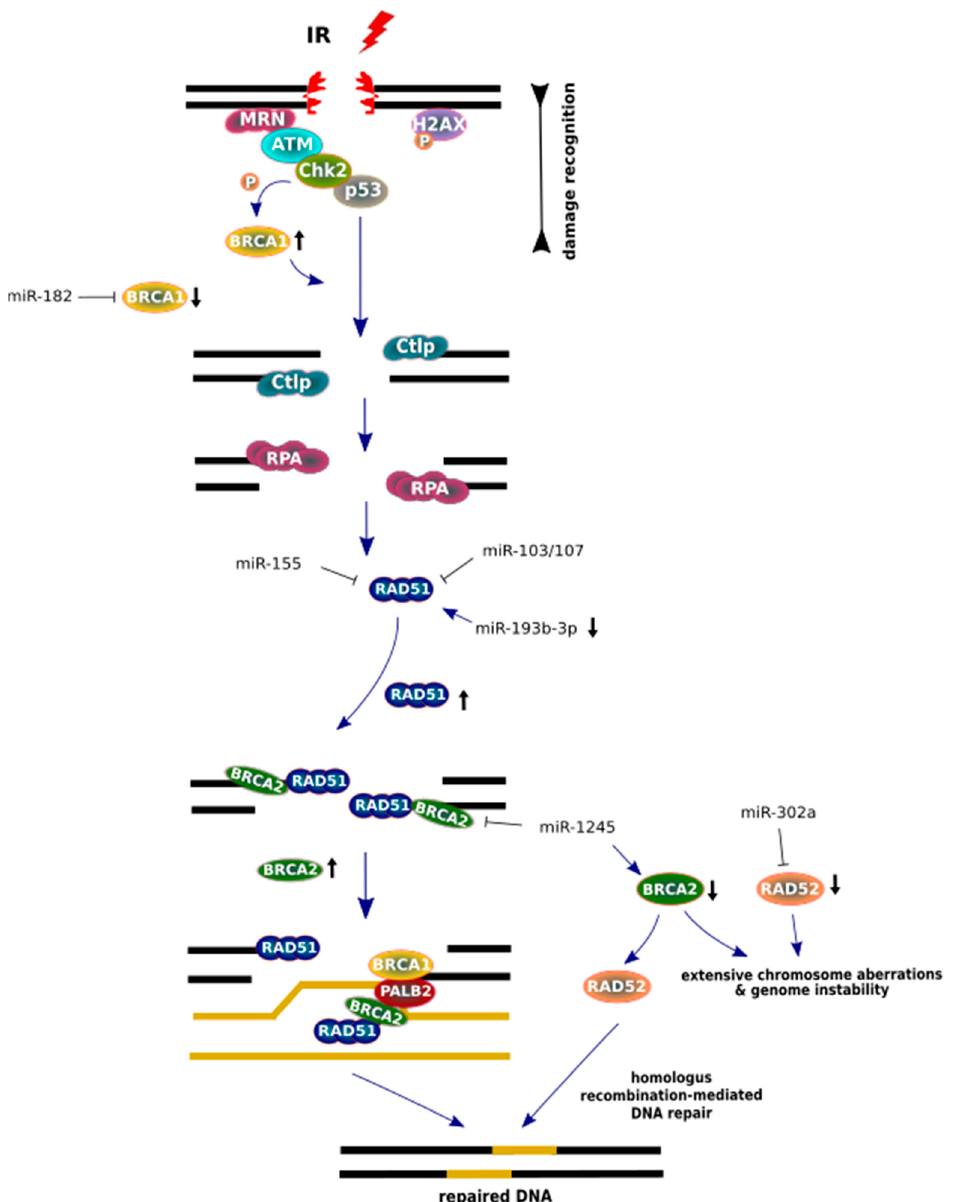
Figure 5. MiRNA regulation of homologous recombination (HR) repair factors after IR. After double strand break (DSB) recognition, BRCA1 (black arrow, pointing up) is phosphorylated by Chk2 kinase and an endonuclease CtIP is delivered for promotion end resection. While, at a later step of HR, BRCA1 recruits PALB2, which mediates promotion of BRCA2 to arrangement on the DNA template. Active BRCA2 (black arrow, pointing up) proteins displaces replication protein A (RPA) in order to load RAD51 onto the DNA. However, low BRCA2 protein levels cause increased levels of RAD52, which promote RAD51 for accurate homologous recombination (HR) repair in BRCA2-deficient cells. The lack of BRCA2 and RAD52 (black arrow, pointing down) causes the most severe genome defects. Major components of the HR pathway are arranged in a scheme based on the aspect of the miRNA regulation post-IR.